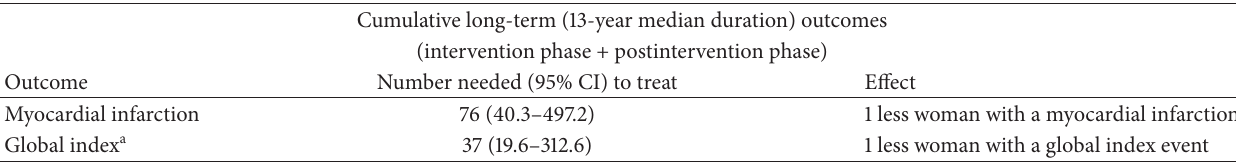
Figure 2: Outcomes for women 50-59 years of age at trial entry, conjugated equine estrogens (CEE) versus placebo, cumulative long-term follow-up (13 years), and WHI Estrogen-Alone Trial. ∗ Global index represents the first event for each participant from among the following: coronary heart disease (nonfatal MI or coronary death), stroke, pulmonary embolism, breast cancer, colorectal cancer, hip fracture, or death due to other causes. CEE: conjugated equine estrogens; CHD: coronary heart disease; CI: confidence interval; DVT: deep vein thrombosis; outcomes: [3]. Table 3: Number of women needed to treat (randomized to CEE) to prevent one woman from developing a myocardial infarction or global index event, women aged 50–59 years at trial entry, Women’s Health Initiative Estrogen-Alone Trial, and cumulative long-term